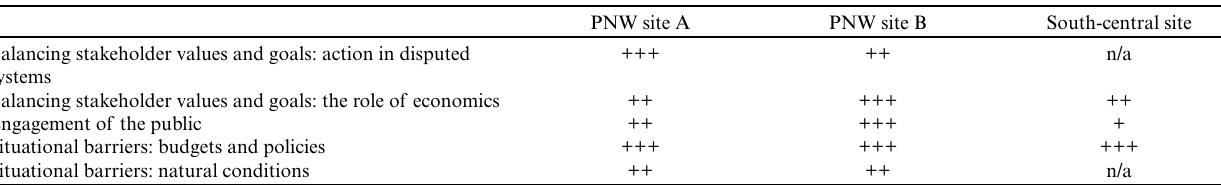
Table 3. Perceived importance of collaborative challenges.